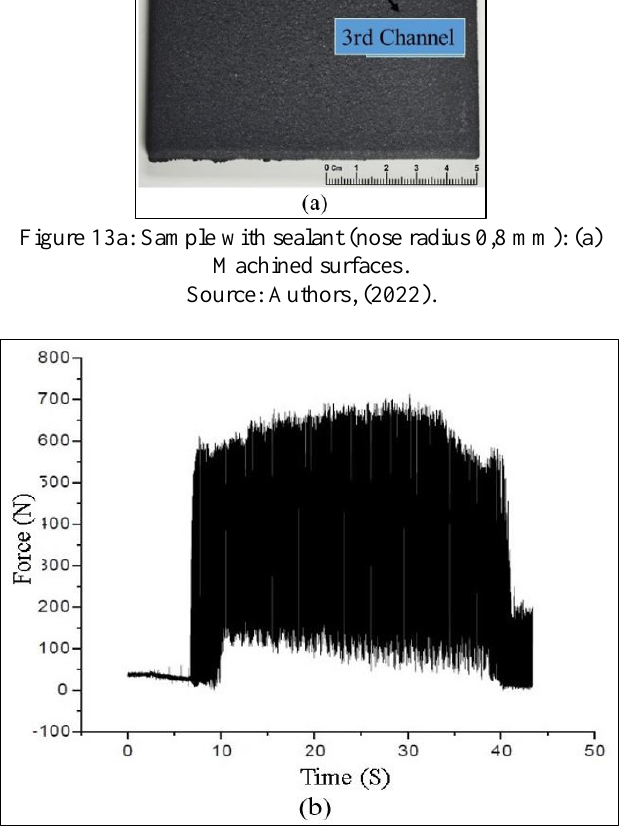
Figure 13b: Sample with sealant (nose radius 0,8 mm): (b) Force spectrum (3rd